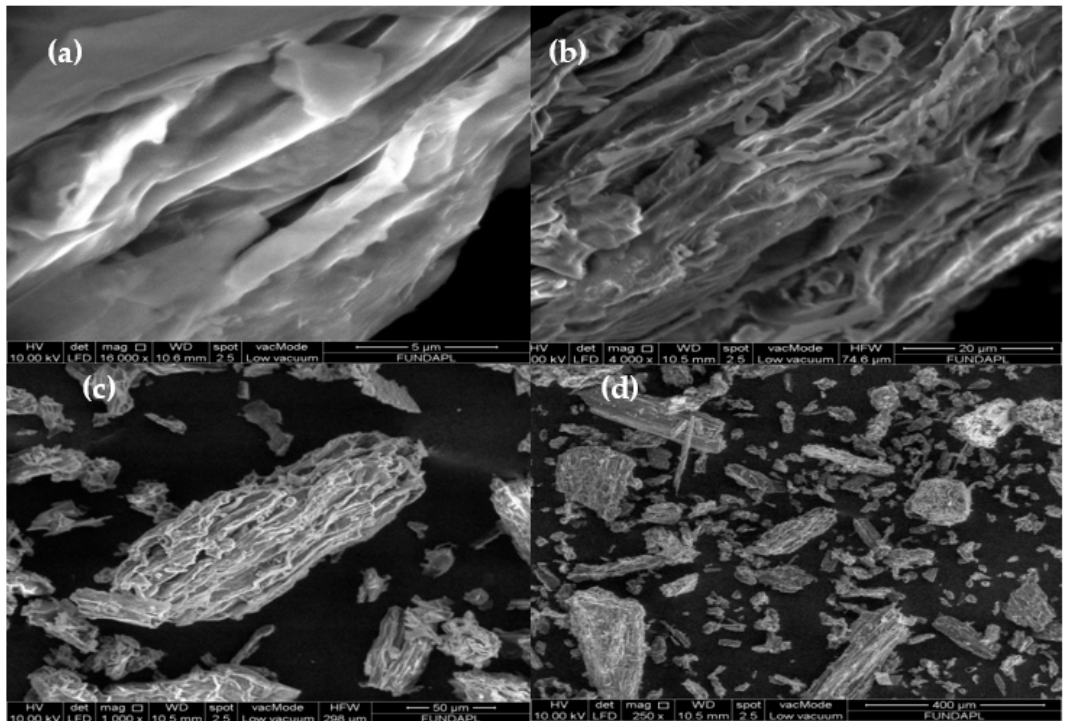
Figure 2. SEM of ALP prior adsorption with different magnifications (( a ): 5 µm), (( b ): 20 µm), (( c ): 50 µm) and (( d ): 400 µm).